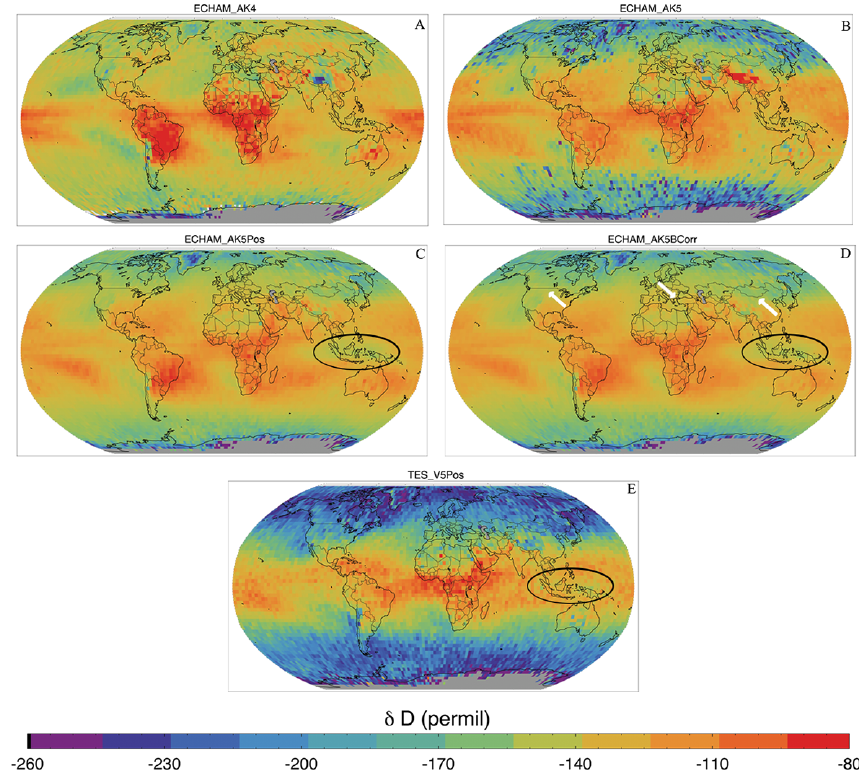
Figure 2. δ D product from ECHAM AK4 (a) , ECHAM AK5 (b) , ECHAM AK5Pos (c) , ECHAM AK5Corr (d) , and TES V5Pos plot (e) . All figures are weighted averaged between 900 and 425hPa. The ECHAM AK4 result is bias-corrected by 3%. Arrows in (d) point out the continental effect, and ellipses in (c) , (d) , and (e) show the region with a strong isotope amount effect around Indonesia. All plots are annual average δ